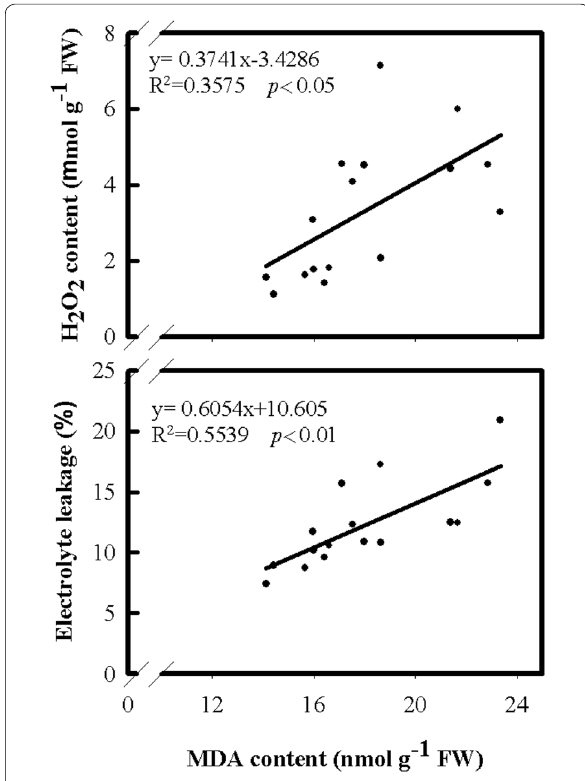
Fig. 5 The relationships of root MDA contents with rice root H 2 O 2 contents and rate of electrolyte leakage under cold treatment among eight cultivars. The temperature was set at 15 °C for cold treatment and 27 °C for control. After 4 days of treatment, the temperature was adjusted to 27 °C for 3 days before